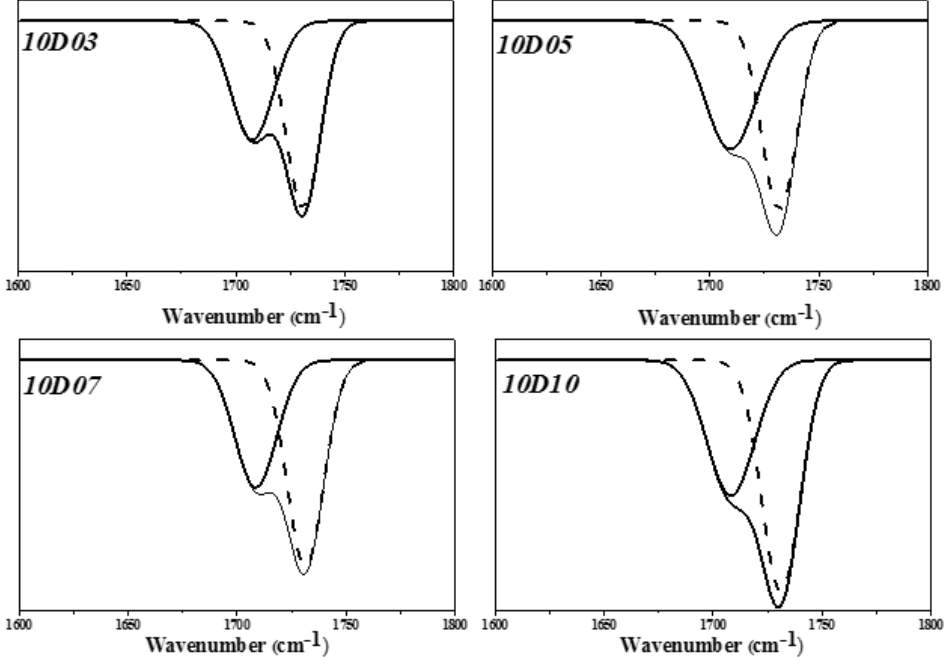
Figure 5. Simulated peak splitting diagrams of FT-IR spectra of –NH group. Table 3. Area percent data of simulated peak splitting of –C=O and –NH.